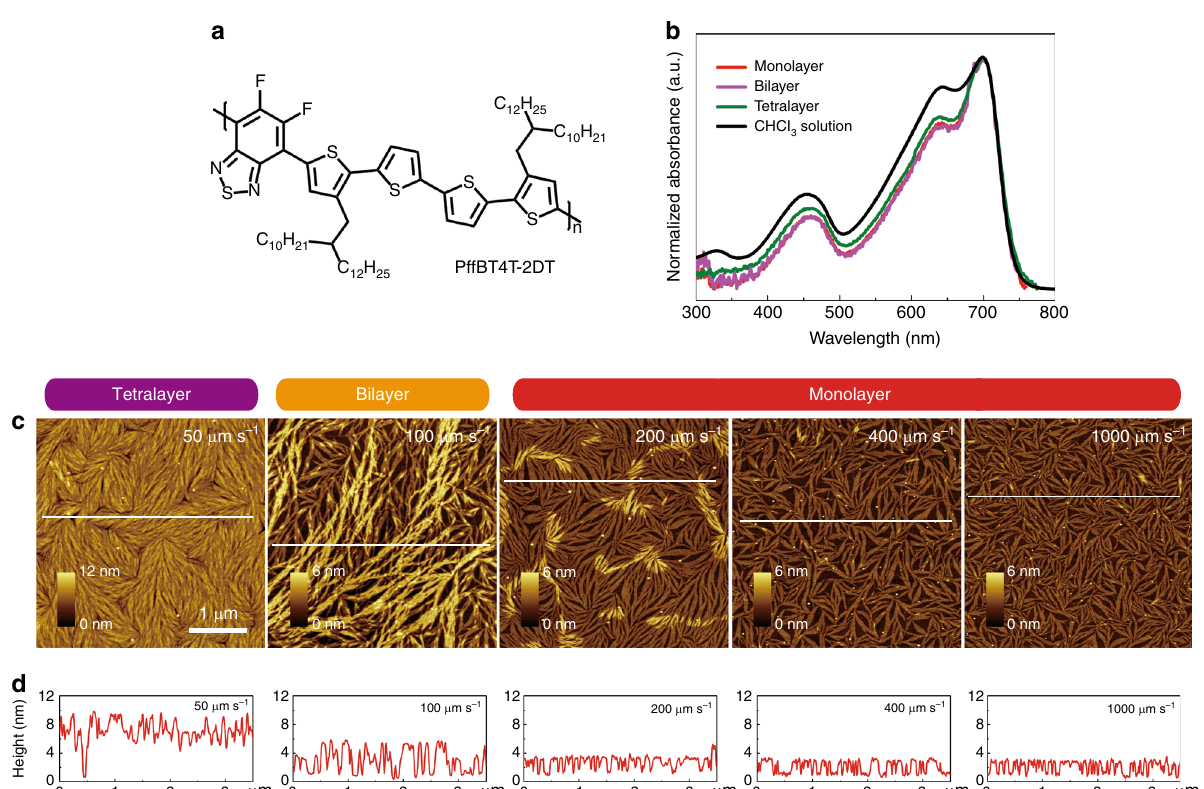
Fig. 1 Optical properties and microstructures of PffBT4T-2DT mono- to multilayers. a Chemical structure of PffBT4T-2DT. b UV – Vis absorption spectra of PffBT4T-2DT as thin fi lms and in solution of chloroform (0.025 mg mL − 1 , 25 °C). Thin fi lms are deposited on quartz wafers by dip-coating from 0.5 mg mL − 1 chloroform solution at room temperature. c AFM images of PffBT4T-2DT ultrathin fi lms from multilayers down to monolayer obtained at different dip- coating speeds (50, 100, 200, 400, and 1000 μ m s − 1 ) from 0.5 mg mL − 1 chloroform solution. All AFM images have the same scale x , y , and z bars except the height scale of the tetralayer. d The corresponding height pro fi les along the indicated lines in c